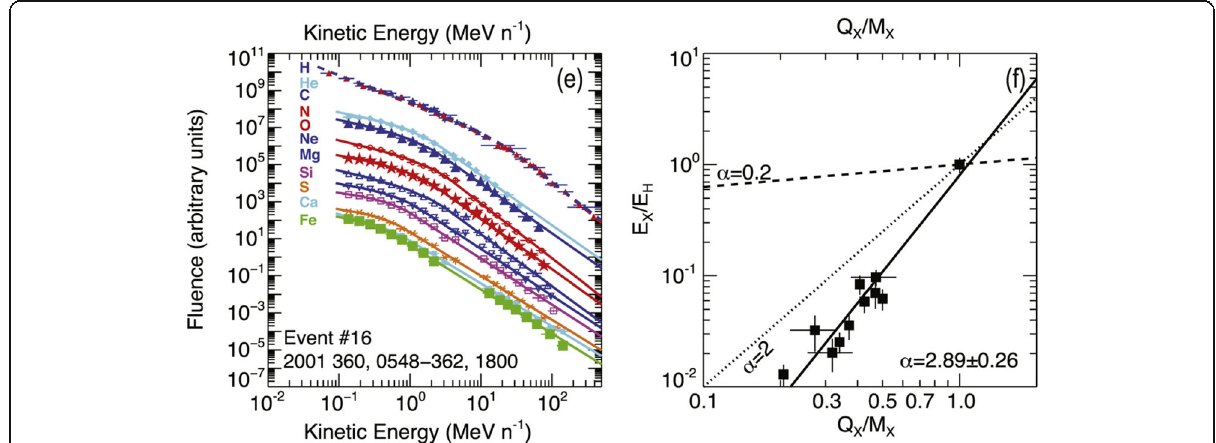
Fig. 26 a Event-integrated differential fluences vs. energy of ~ 0.1 – 500 MeV/nucleon for H-Fe nuclei during a large SEP event, taken from Desai et al. (2016b). The energy spectra for different species are offset for clarity. Solid lines are Band function fits to the spectra. b Spectral break energy E X of species X normalized to E H — break energy of H vs. the ion ’ s charge-to-mass (Q/M) ratio. Solid lines are fits to the data E X /E H = no (Qx/Mx) α ; dashed line: same equation with α = 2; dotted line: same equation with α =